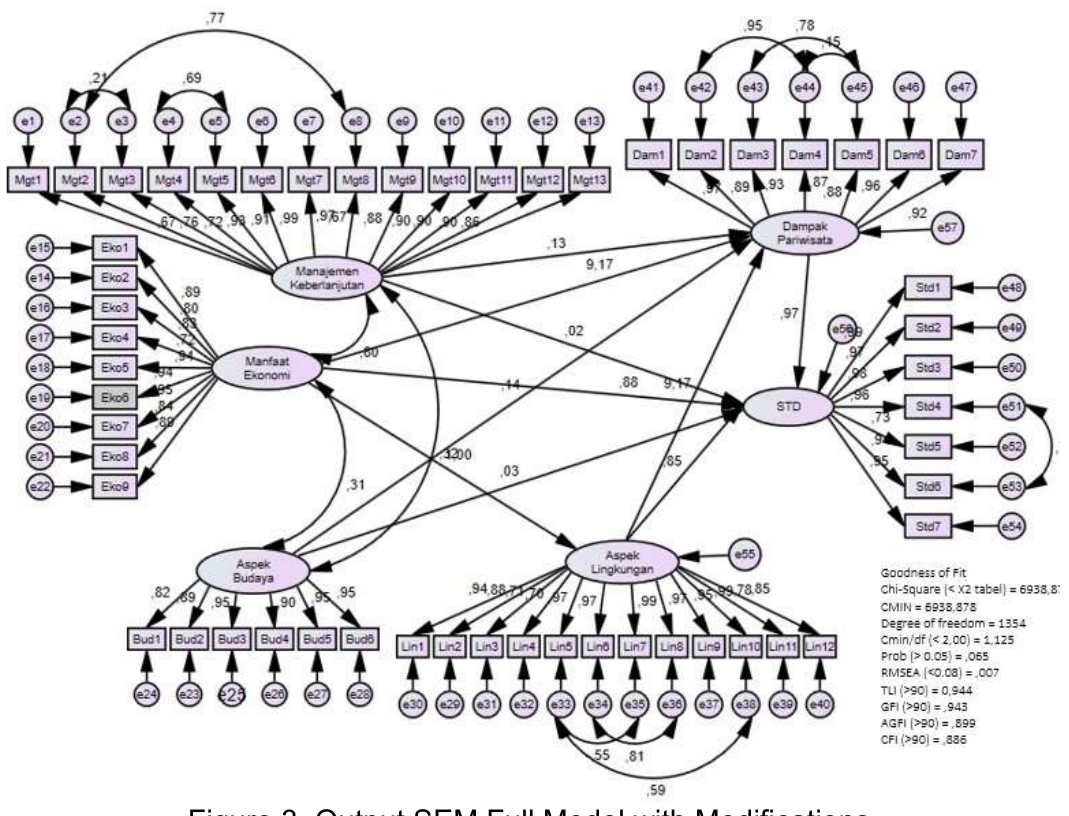
Figure 3. Output SEM Full Model with Modifications